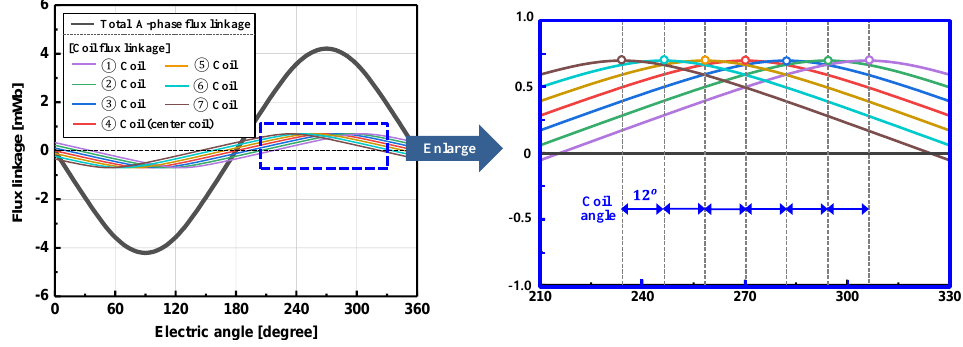
Figure 11. Total flux linkage and each flux-linkage waveform of M3.